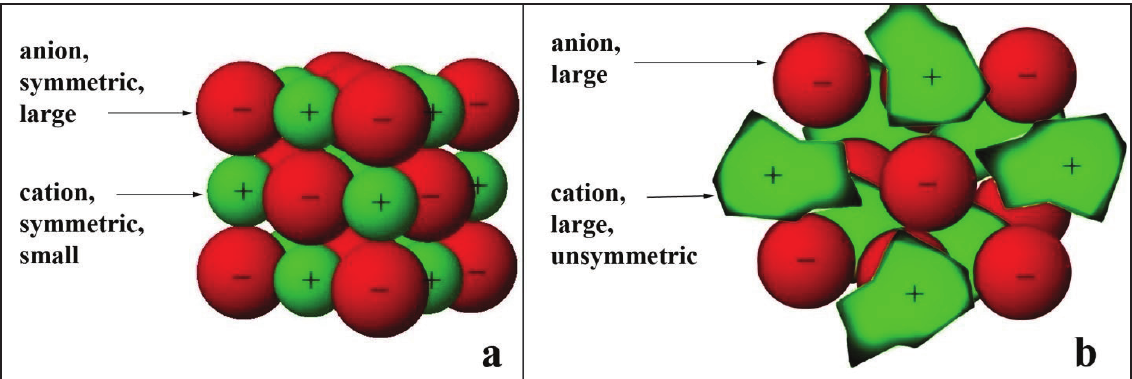
Fig. 1. Charge distribution in common salts (a) and ILs (b).